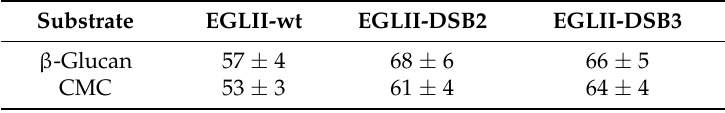
Table 1. The specific activities (U/mg protein) of recombinant EGLII forms.